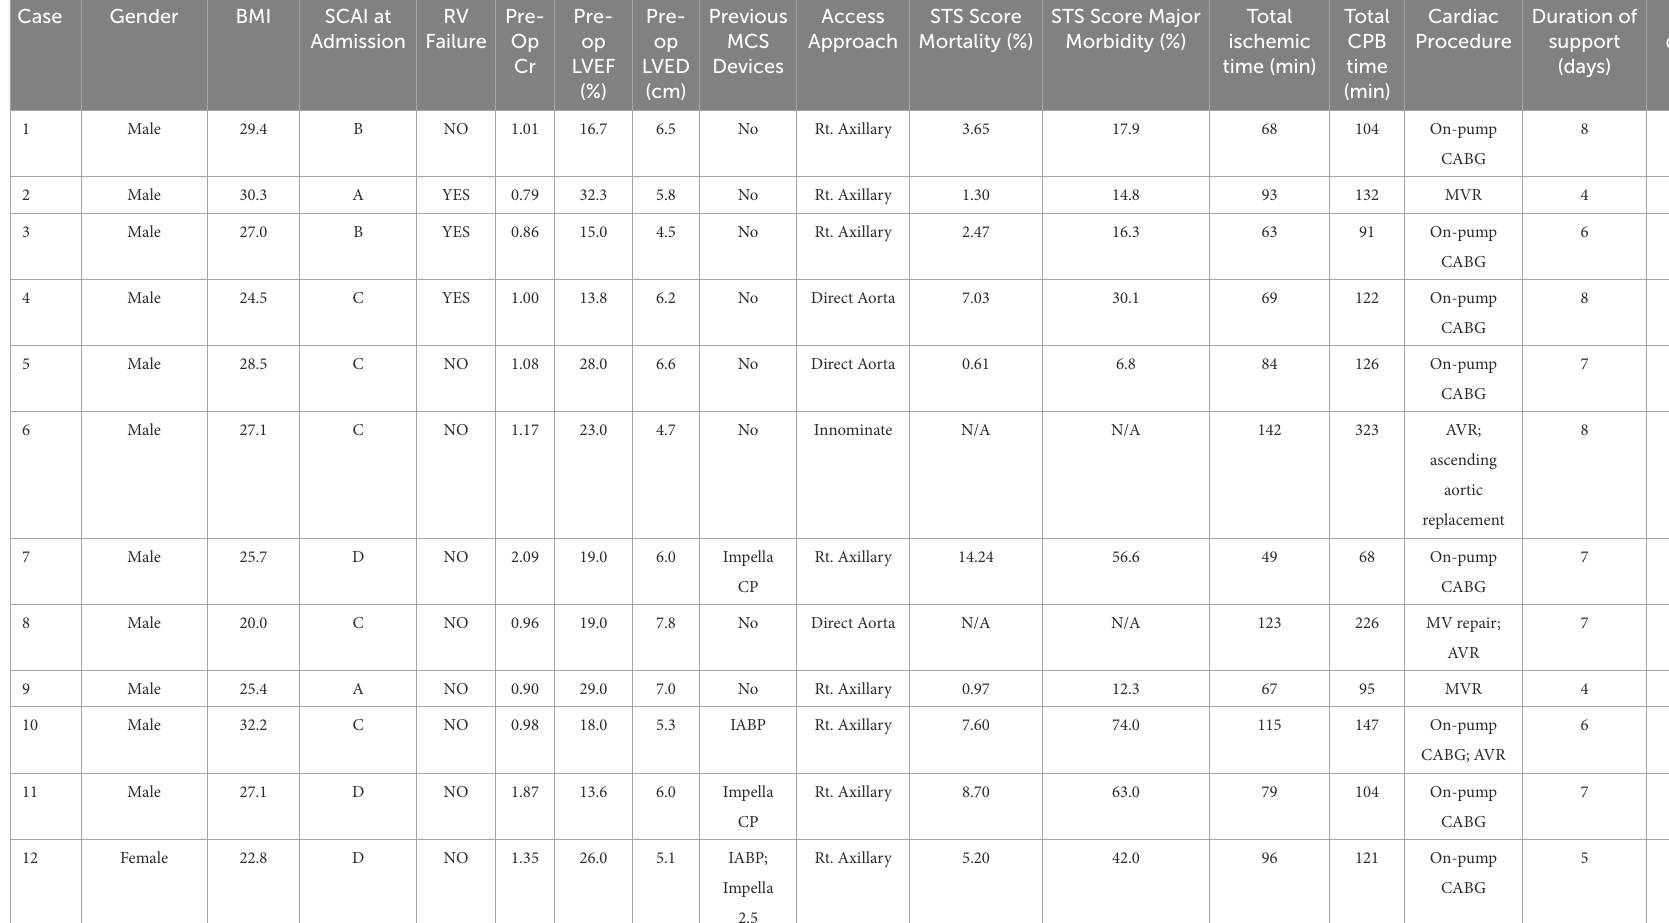
TABLE 3 Outcomes for Impella-supported cardiac